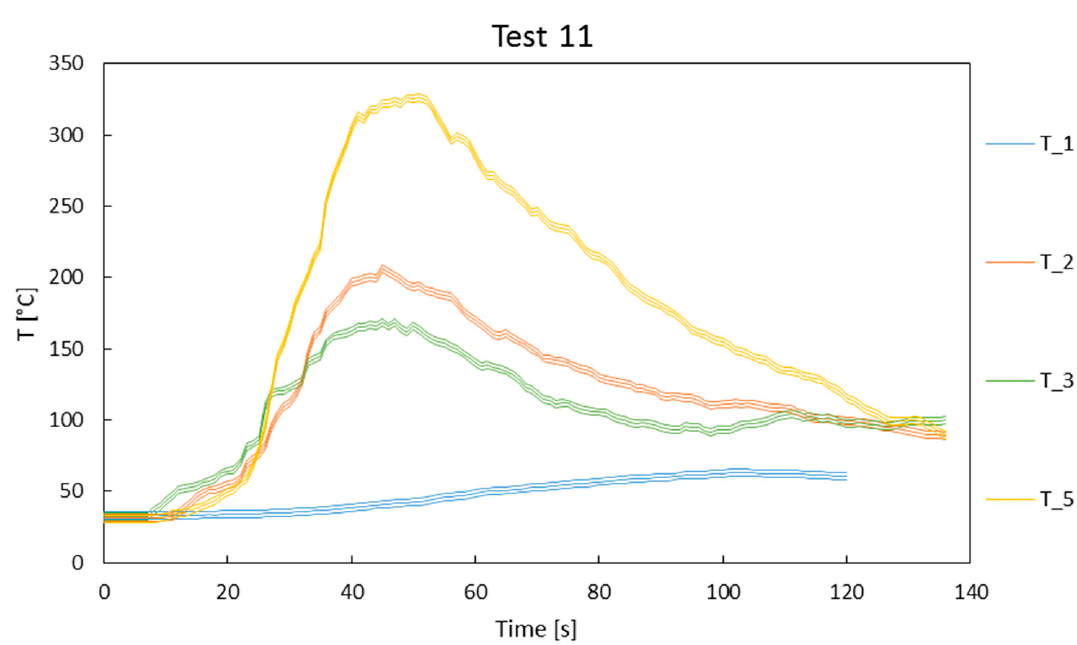
Figure 8. Evolution of temperatures in Test 11.